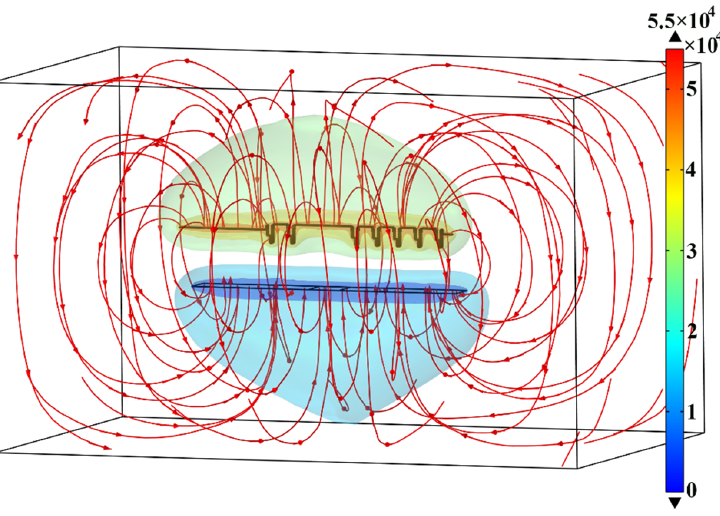
Figure 3. COMSOL Multiphysics simulation output.